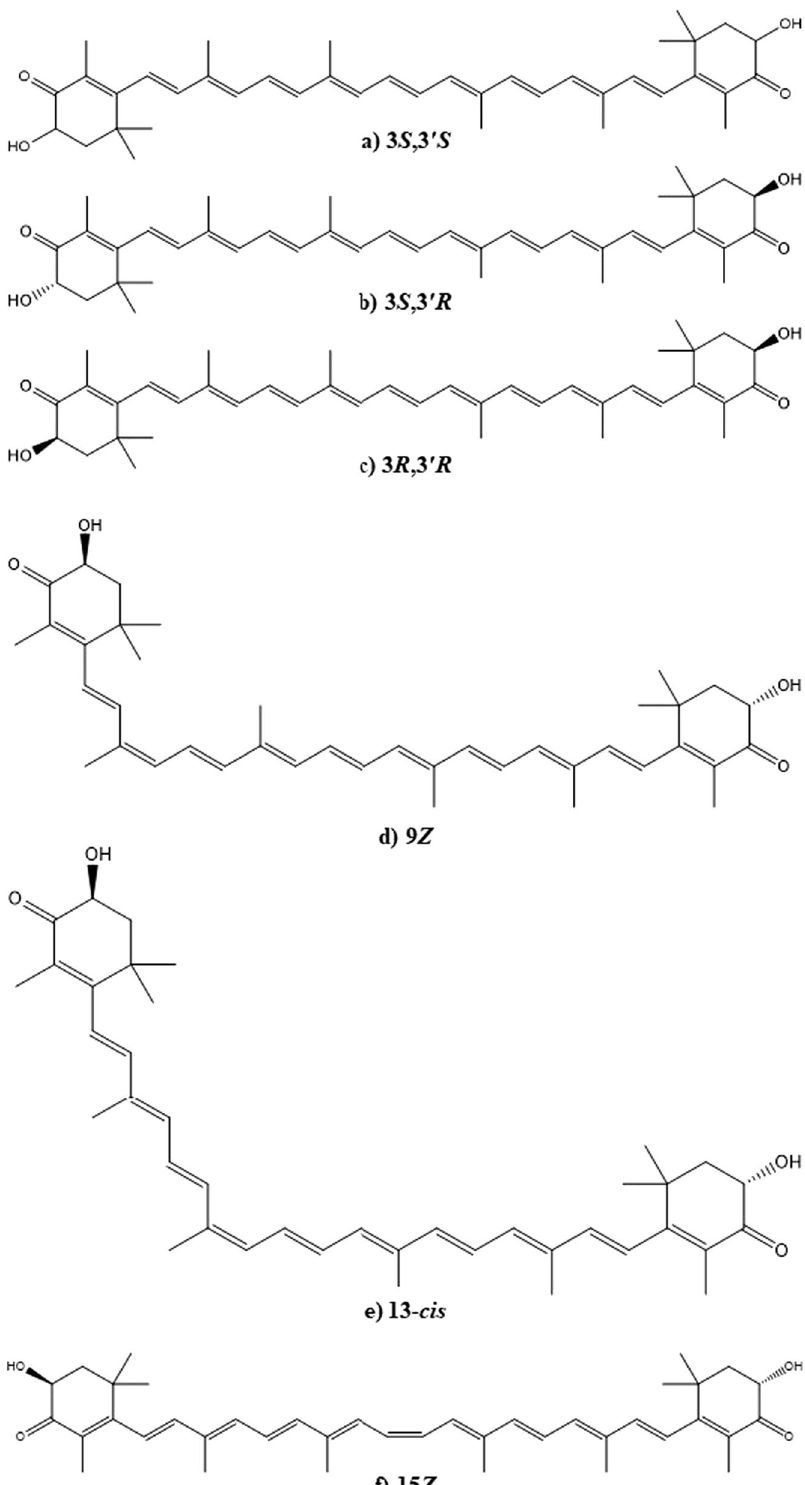
Fig. 2 Structures of optical isomers ( a – c ) and geometric isomers ( d – f ) of the